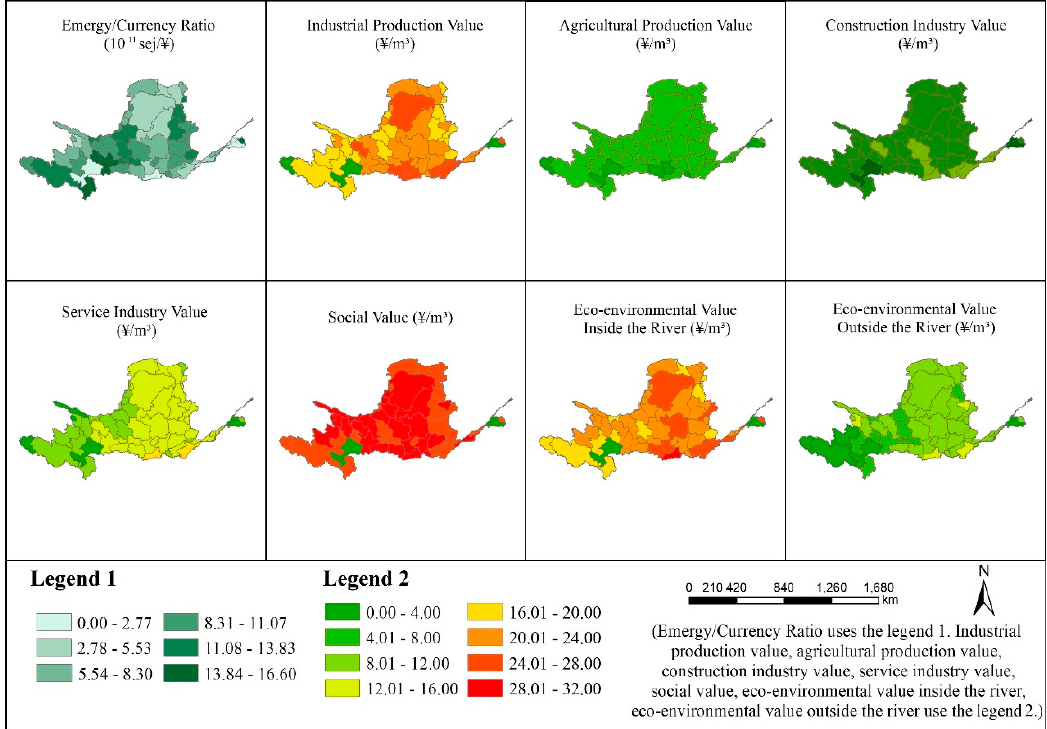
Figure 3. Water resource value atlas of the Yellow River Basin.